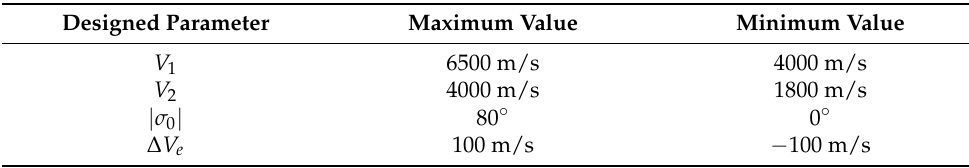
Table 1. The limitation of designed parameters.